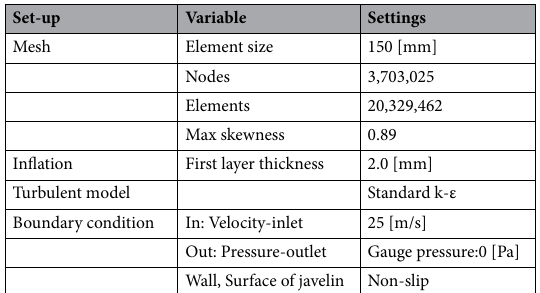
Table 1. Summary of meshing and boundary conditions.